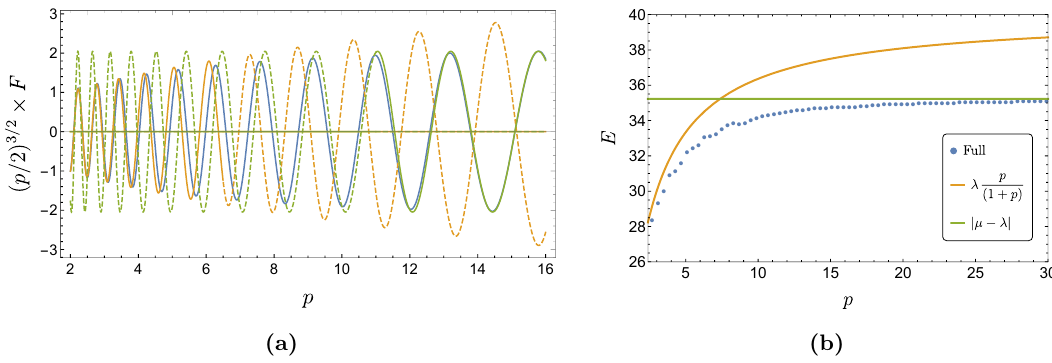
= 5 H and λ = 40 H , using (a) eff